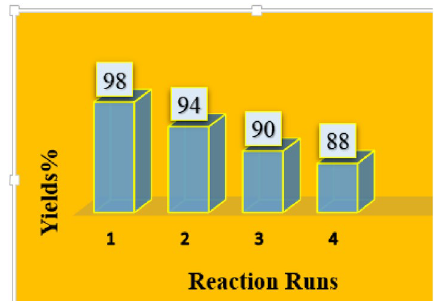
Figure 10. Catalyst recycling experiments.